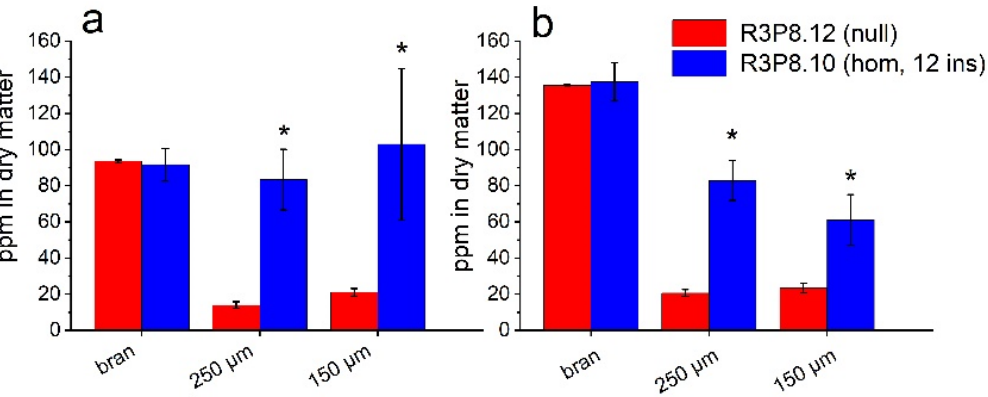
Figure 10. Mineral (Fe and Zn) content as ppm in dry matter of three different flour fractions (bran, 250 μm, and 150 μm mesh) of field grown AsWRI1 -wheat at grain maturity (line R3P8.12, null (control); line R3P8.10, homozygous with 12 gene inserts). ( a ) Fe content. ( b ) Zn content. Results are mean values of three replicates (i.e., field plots) ± standard deviation. Bars marked with asterisks are significantly different to control (null) according to Fisher’s pairwise comparisons ( p < 0.05).